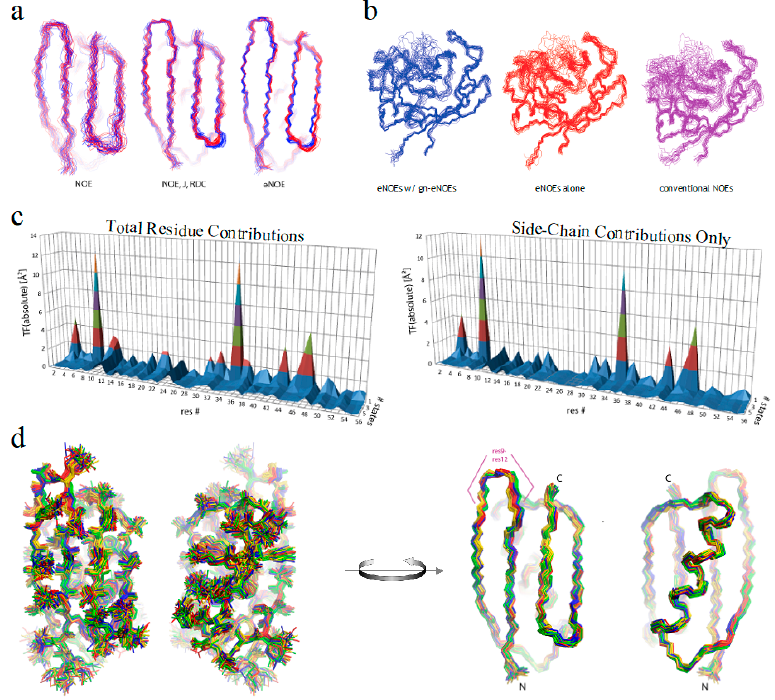
Figure 5. Recent eNOE advances. ( a ) Two-state ensembles of GB3 calculated from conventional NOEs, NOEs supplemented with RDCs and J couplings, or from eNOEs alone, from right to left, respectively. Adapted from Journal of Structure Biology, 191, Vögeli, Olsson, Riek, Güntert, Complementarity and congruence between exact NOEs and traditional NMR probes for spatial decoding of protein dynamics [33], 306–317, Copyright (2015), with permission from Elsevier; ( b ) Single-state structural ensembles of cyclophilin A calculated using 1254 eNOEs supplemented with 2217 generic normalized eNOEs (left), 1254 eNOEs alone (middle), or using 4537 conventional NOEs (right); ( c ) Residue-specific target function (TF) values. The individual contributions are plotted versus the residue number and the number of states on the x and y axes, respectively. On the left are the contributions from the entire residue, while the right are only those from the side-chain atoms. Adapted from Journal of Biomolecular NMR, 62, Chi, Strotz, Riek, Vögeli, Extending the eNOE data set of large proteins by evaluation of NOEs with unresolved diagonals, 63–69, Copyright (2015), with permission from Springer; ( d ) Heavy-atom (left) and backbone (right) representations of the four-state GB3 structural ensemble are shown. The 20 conformers with the lowest TF values were selected, and the four states colored gold, red, green, and blue were obtained by grouping the loop comprising residues 9–12. Images ( c ) and ( d ) were both reprinted from [34].